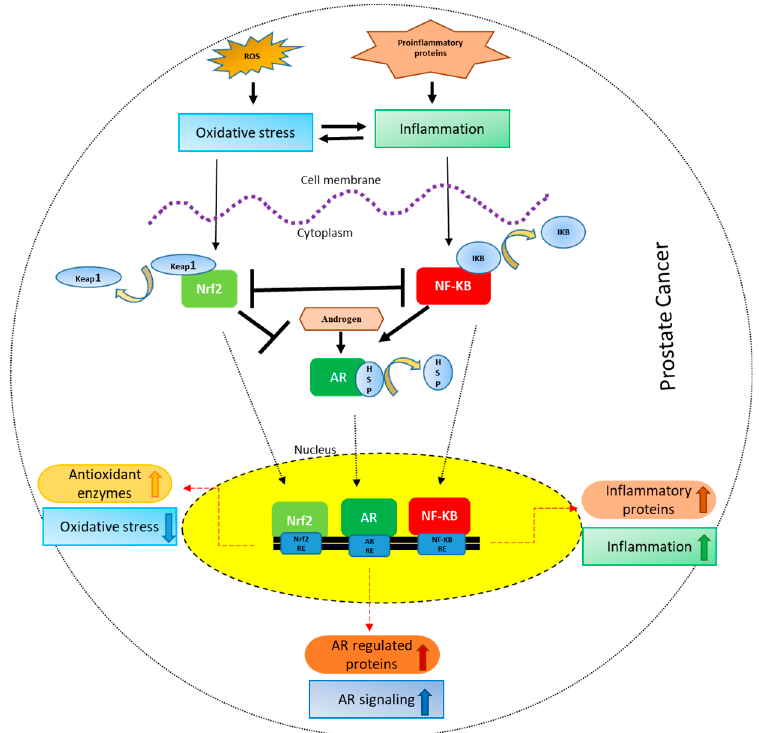
Figure 1. Crosstalk between Nrf-2, NF- κ B and AR in PCa: Oxidative stress leads to inflammation and vice versa. Oxidative stress results in the activation and nuclear localization of Nrf-2 after its dissociation from Keap1. Nrf-2 after localizing to the nucleus binds to the antioxidant response elements leading to the transcription and translation of antioxidant proteins. Inflammation, on the other hand, leads to the activation and nuclear localization of NF- κ B after its dissociation from I κ B, where it binds to NF- κ B response elements leading to the transcription and translation of inflammatory proteins. Nrf2 signaling inhibits NF- κ B signaling and vice versa. On the other hand, Nrf-2 inhibits AR whereas NF- κ B activates AR signaling. AR after binding to androgens dissociates from HSPs (heat shock proteins), translocates to the nucleus leading to the transcription and translation of AR regulated proteins like prostate specific antigen (PSA).